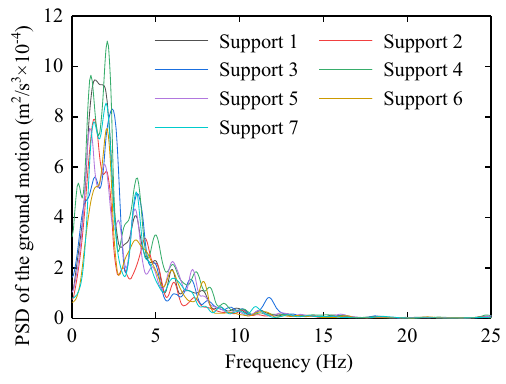
Fig. 11 PSD of the ground motions of case 5